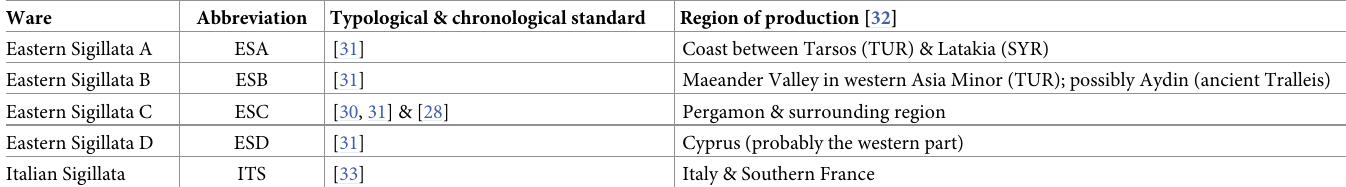
Table 1. Typological, chronological references and possible region of production for major tablewares studied in this paper.